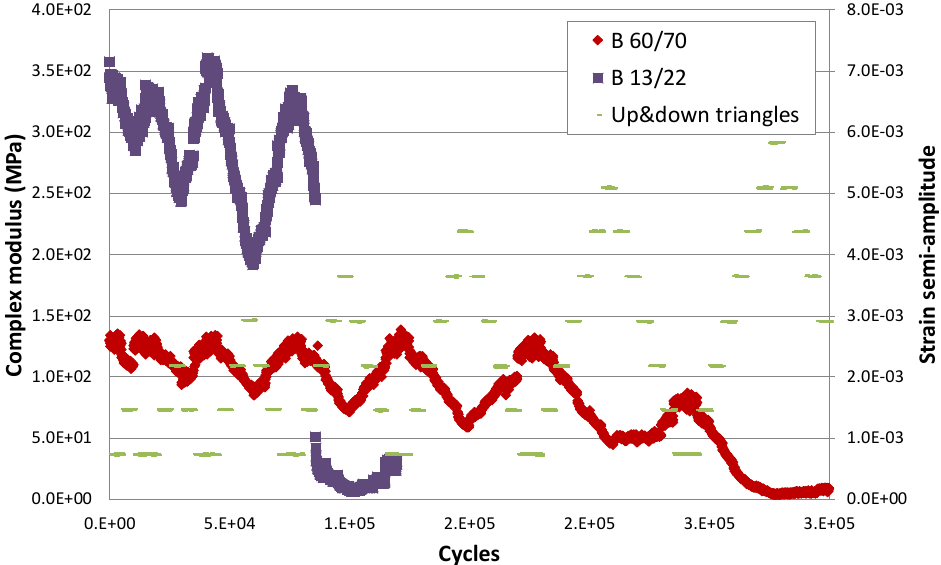
Table 1. Properties of 13/22 and 60/70 bitumens.